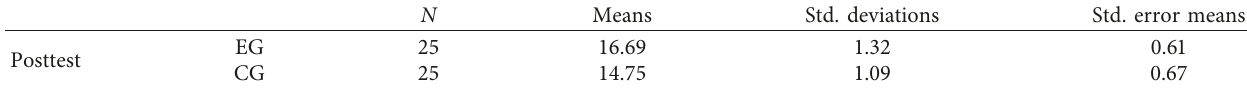
Table 3: Reading posttest DS of both groups.